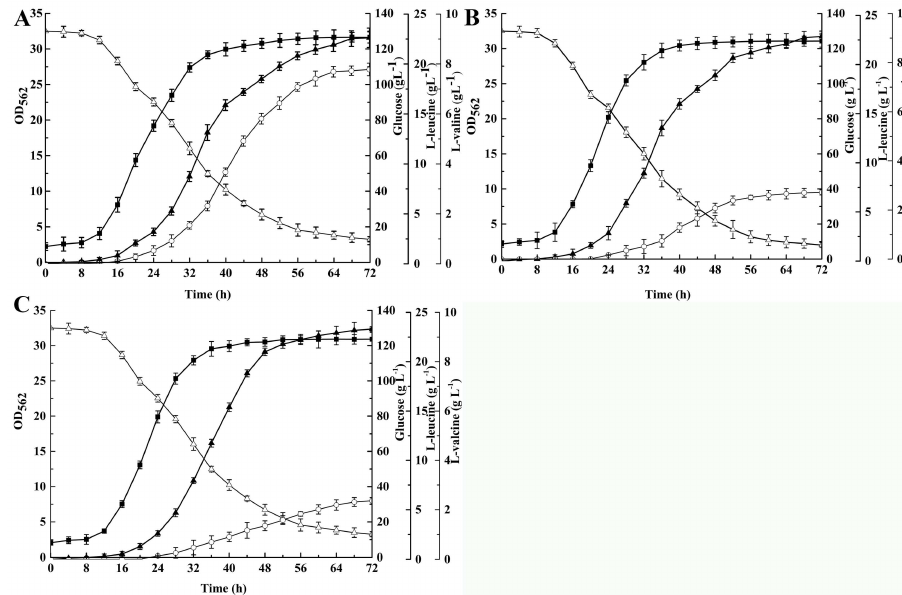
Figure 3. Comparison of the di ff erent C. glutamicum strains during cultivation in shake-flasks with fermentation medium to test the e ff ect of additional reducing equivalents delivered by NADH. ( A ) ∆ LtbR-AHAIR M / ABNC M E, ( B ) ∆ LtbR-AHAIR M LeuDH / ABNC M LDH, and ( C ) ∆ LtbR-AHAIR M LeuDHRocG / ABNC M LDH. Solid squares—OD 562 , hollow triangles—glucose, solid triangles— l -leucine, hollow circles— l -valine. The data represent the mean values and standard deviations obtained from three independent